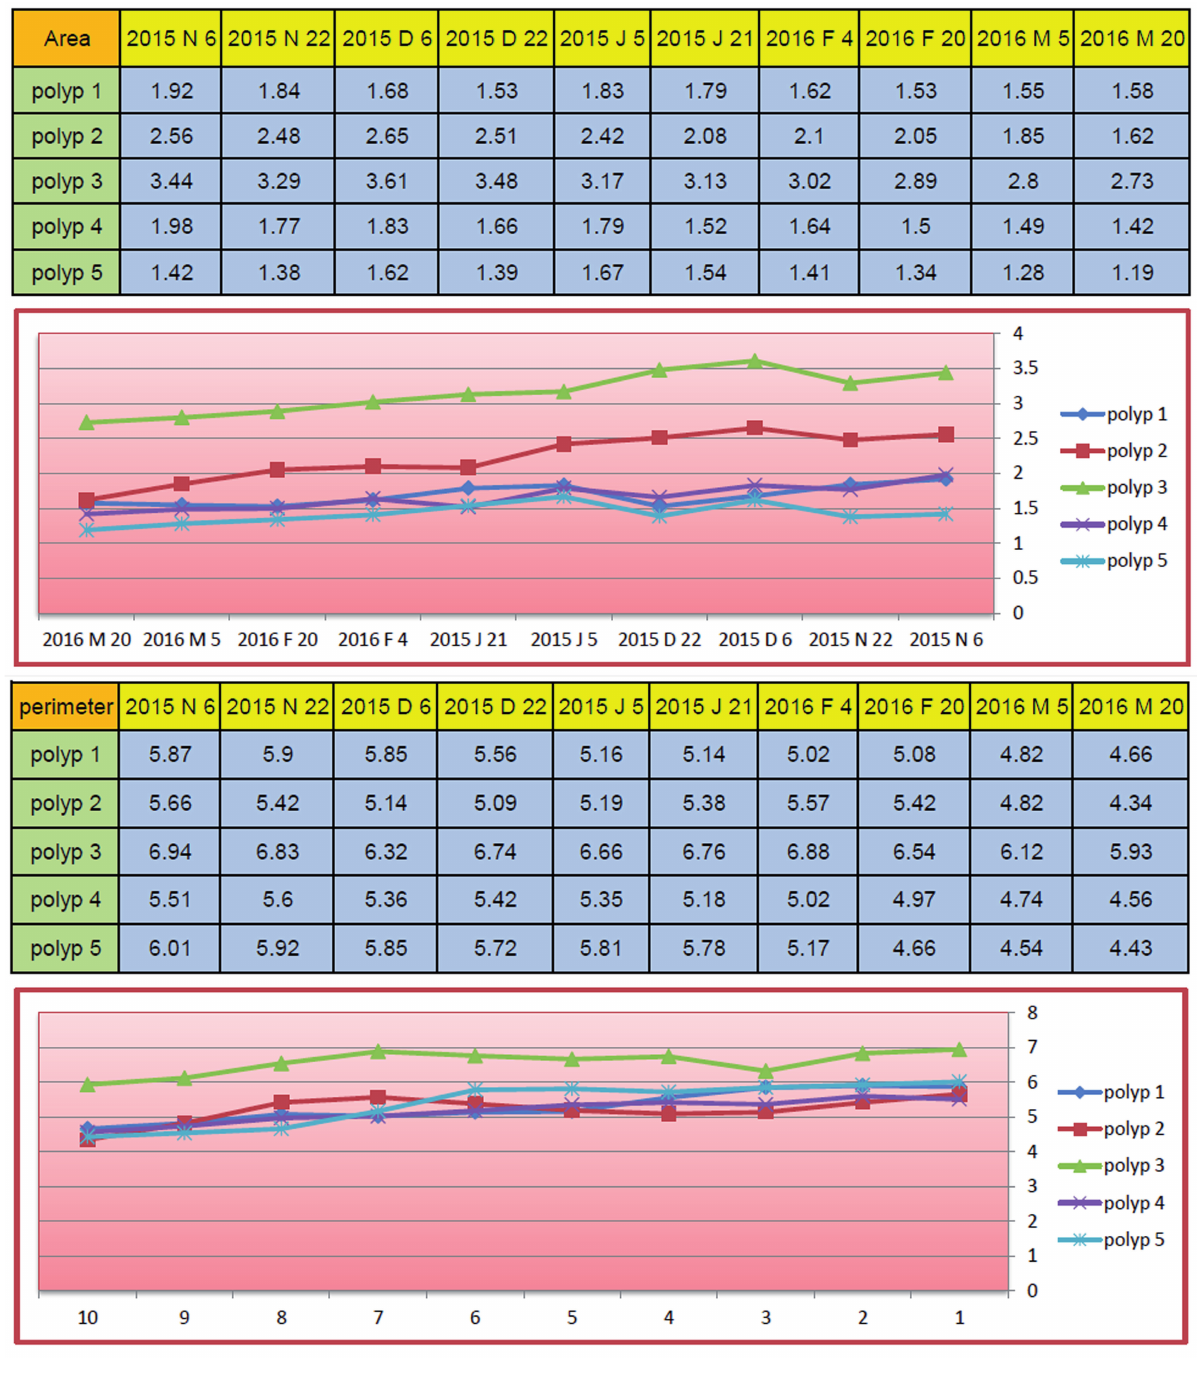
figure 3 - curves of the perimeter and area of each polyp during a period of 15 months in patient